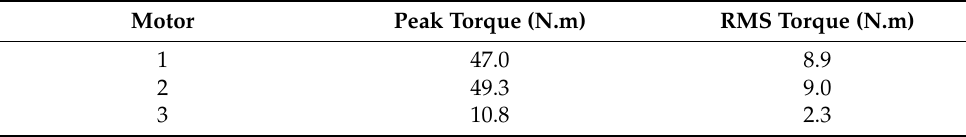
Table 5. Motor sizing for the joints of the SAMA exoskeleton. Motor